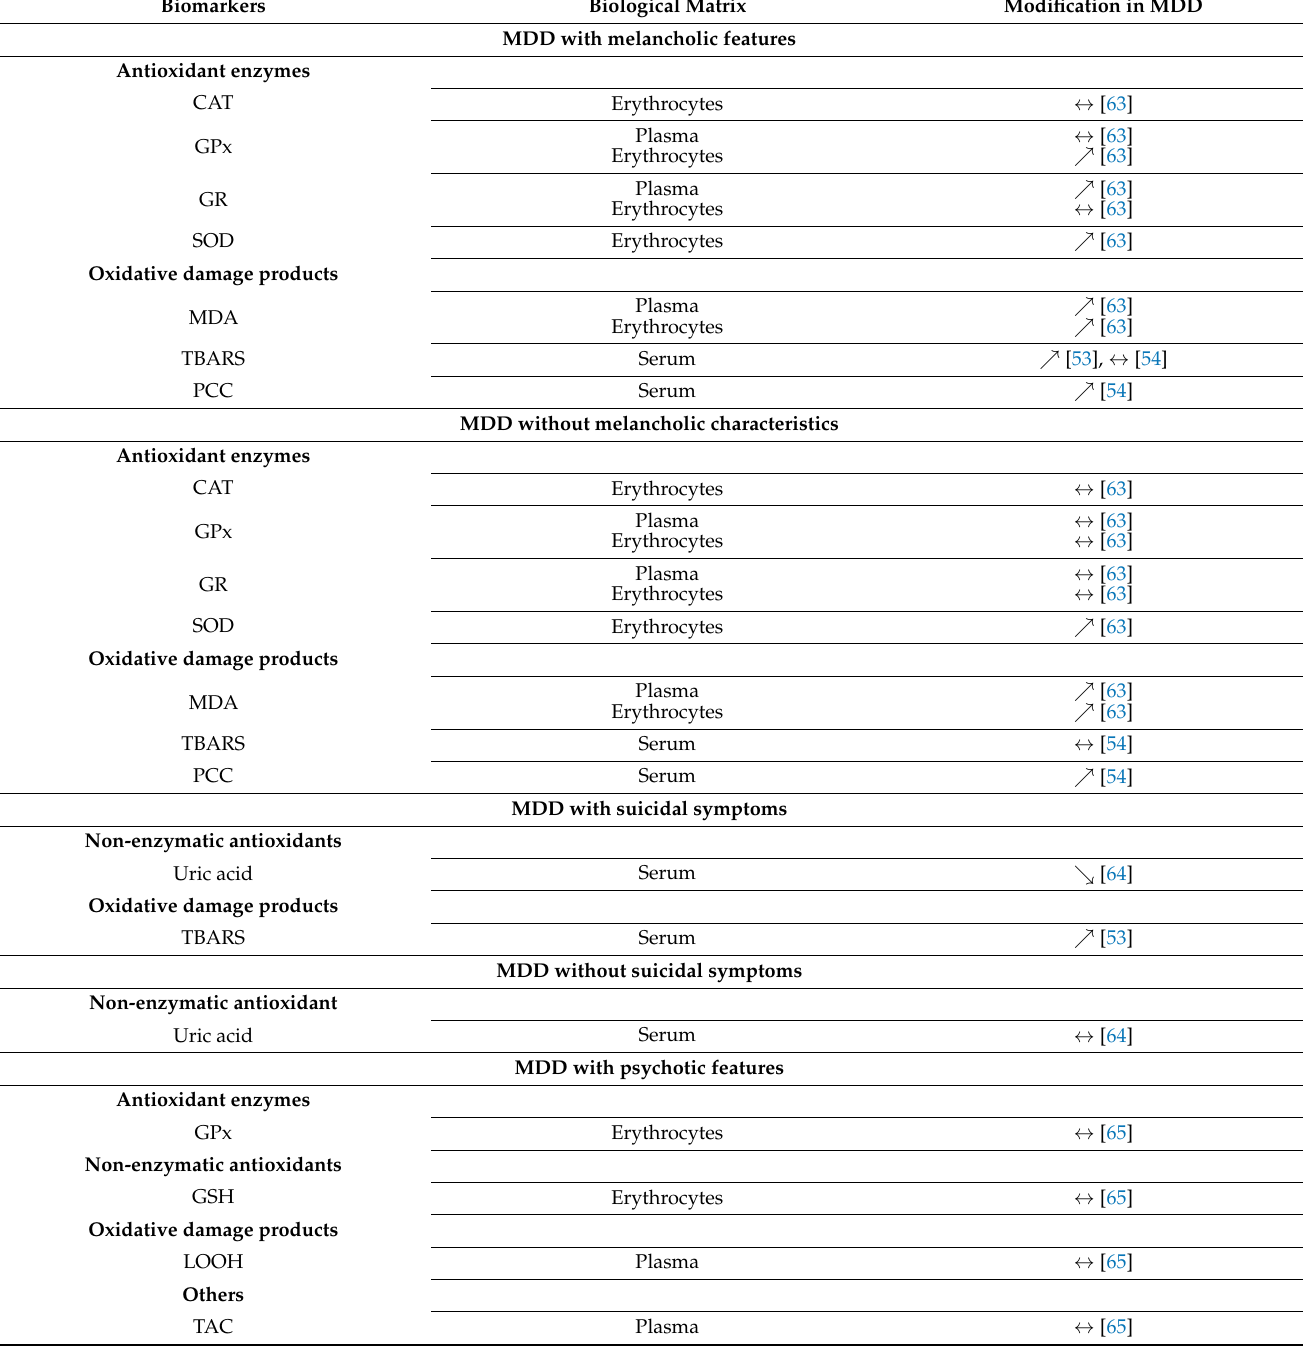
Table 2. Peripheral biomarkers of oxidative stress in MDD patients according to clinical fea- tures compared to healthy controls. MDD: Major depressive disorder—CAT: Catalase—GPx: Glu- tathion Peroxydase—GR: Glutathion Reductase—SOD: Superoxide dismutase (information about isoform was not provided)—GSH: Reduced form of glutathione—MDA: